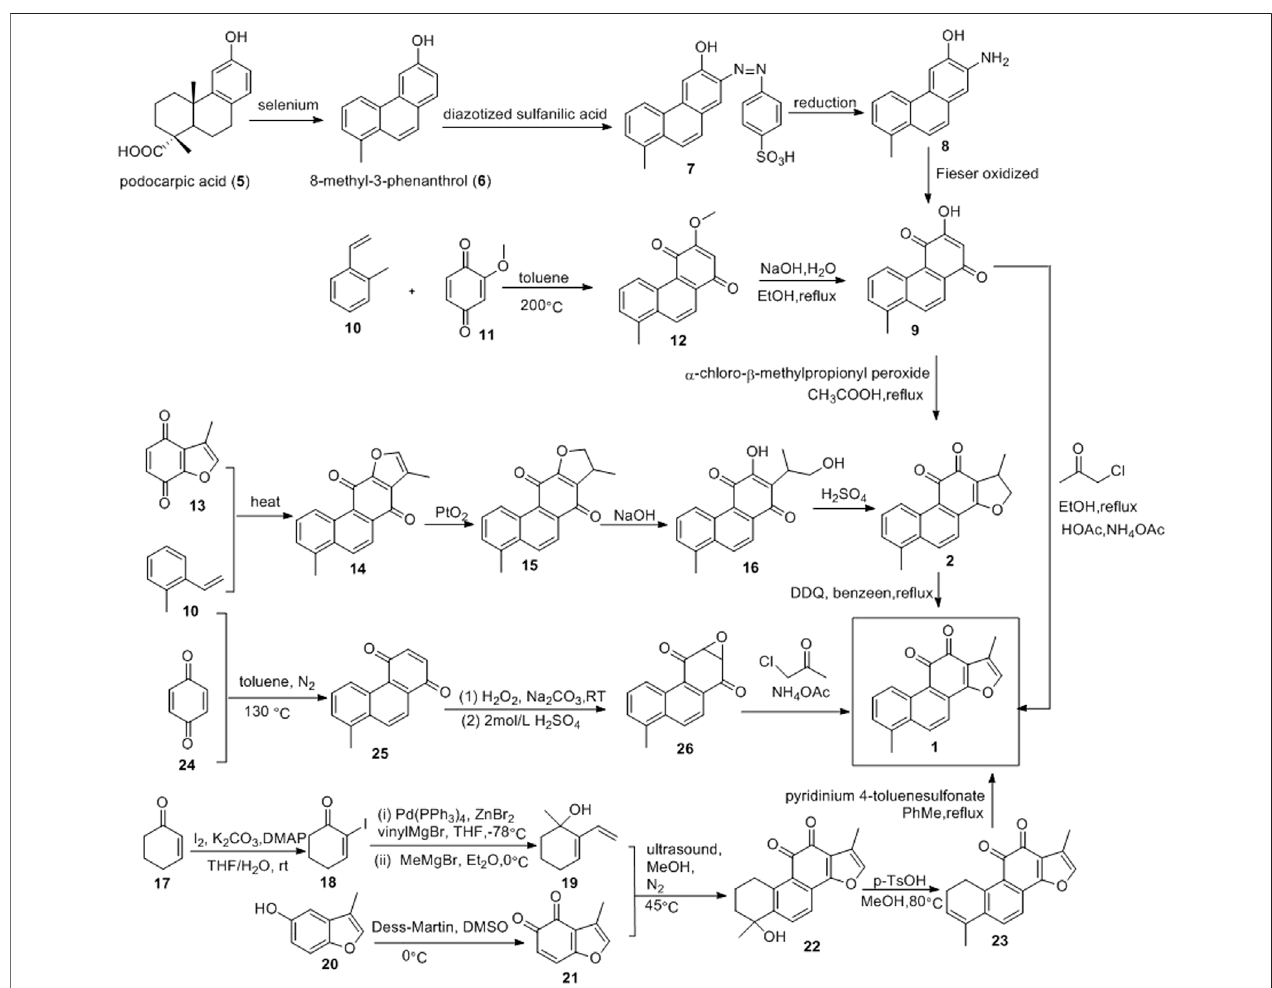
FIGURE 4 | Podocarpic acid synthetic tanshinone I and Diels-Alder addition route.